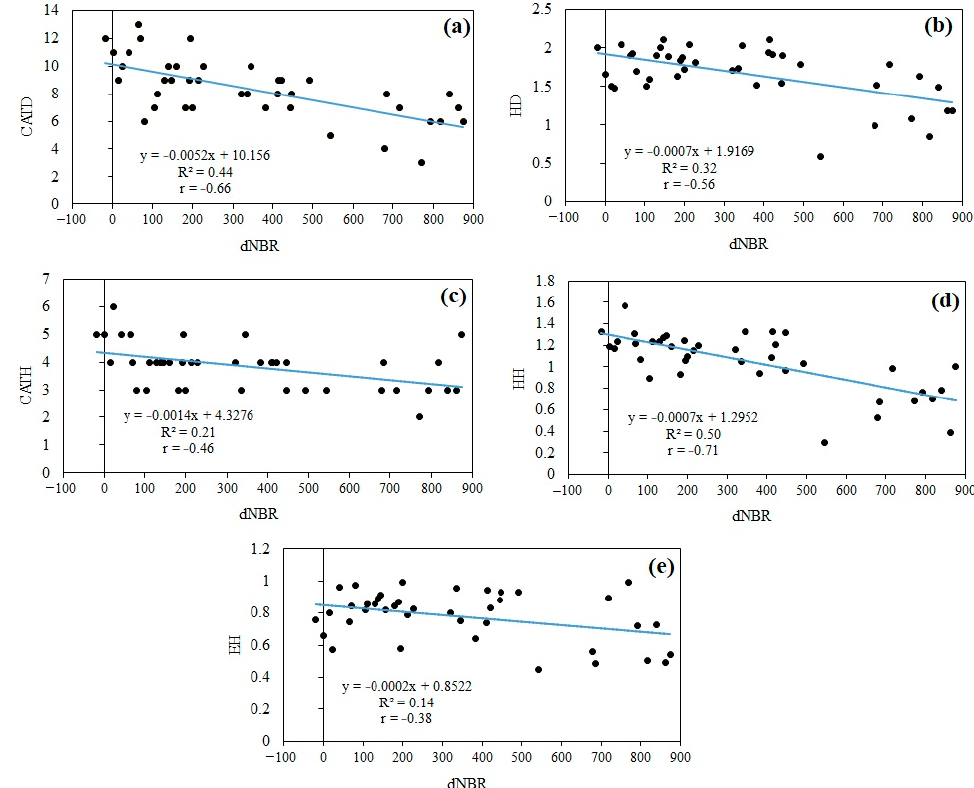
Figure 8. Scatter plots showing the linear association between ( a ) CATD and dNBR; ( b ) H-D and dNBR; ( c ) CATH and dNBR; ( d ) H-H and dNBR; and ( e ) E-H and dNBR.